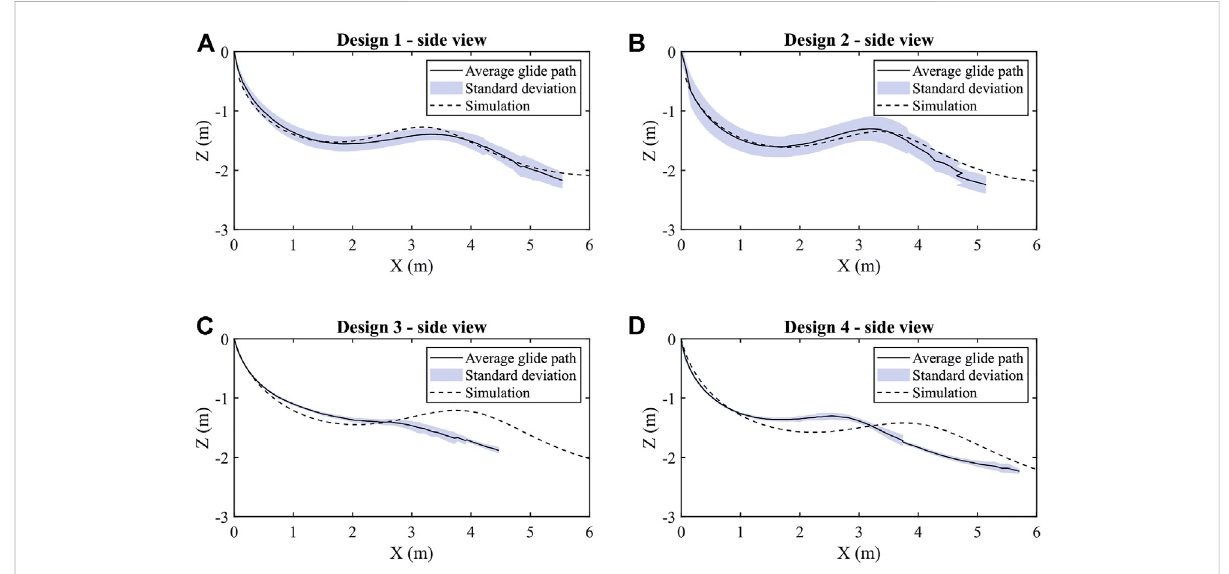
FIGURE 5 Flight paths of the two different shaped gliders with each two different centers of gravity compared with the predictions of the dynamic simulations. (A) givestheaveraged fl ight-path,thestandarddeviationandthesimulationresultsforthegliderdesign1, (B) showstheaveraged fl ight- path,thestandarddeviationandthesimulationresultsforthegliderdesign2, (C) summarizestheaveraged fl ight-path,thestandarddeviationandthe simulation results for the glider design 3, (D) indicates the averaged fl ight-path, the standard deviation and the simulation results for the glider design 4.